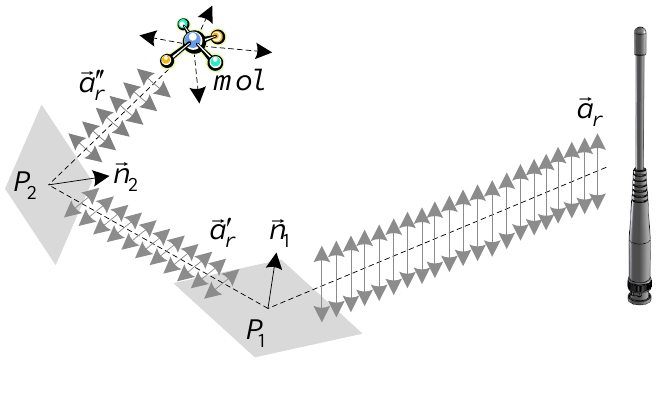
Figure 3. Example of alteration of polarization state of an EM